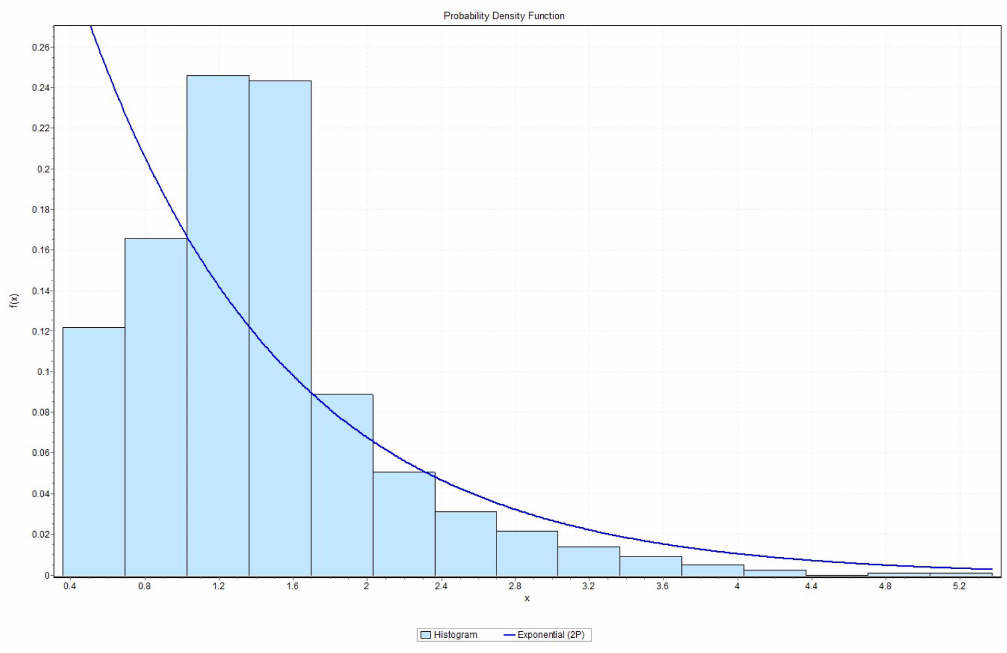
Figure 7. Probability density function for the 2-P exponential distribution during the event of